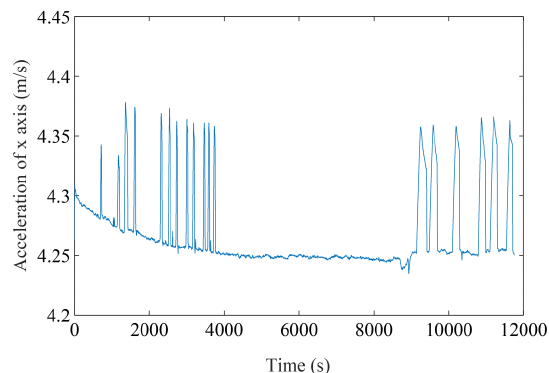
Fig. 2. Acceleration on x axis of accelerometer over time